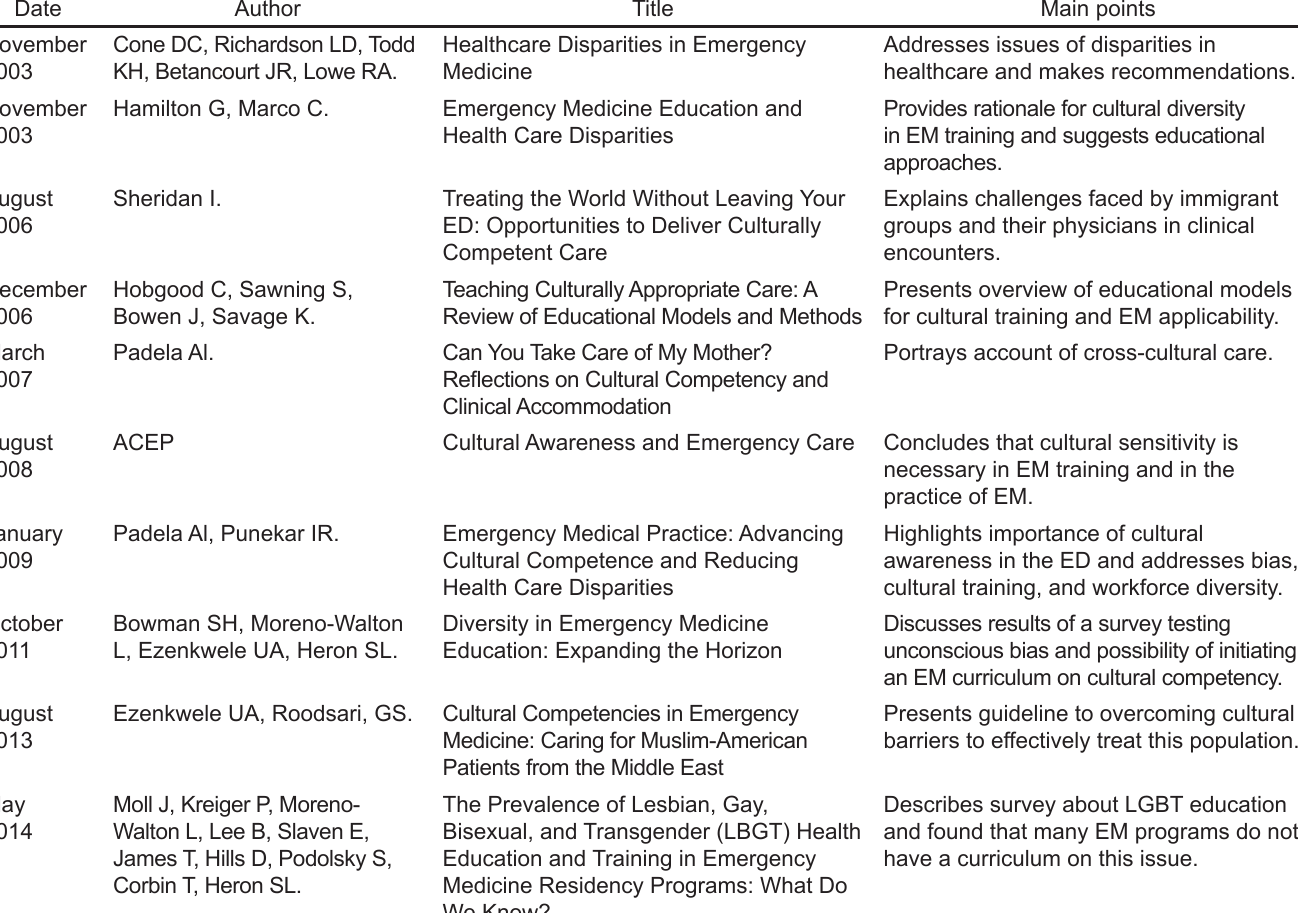
Table. Articles addressing cross-cultural competency in emergency